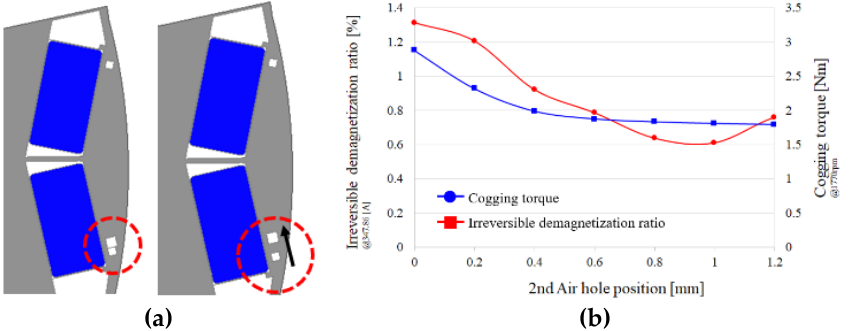
Figure 17. Asymmetric air hole insertion model, and the graph of cogging torque and demagnetization: ( a ) asymmetric air hole insertion model; ( b ) cogging torque and irreversible demagnetization graph.